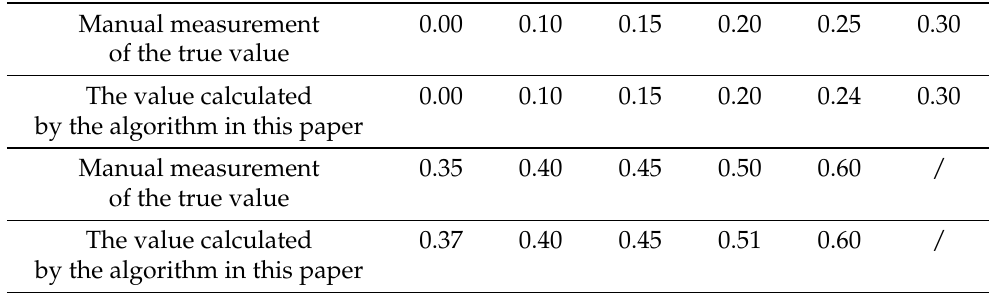
Table 7. Test result table.